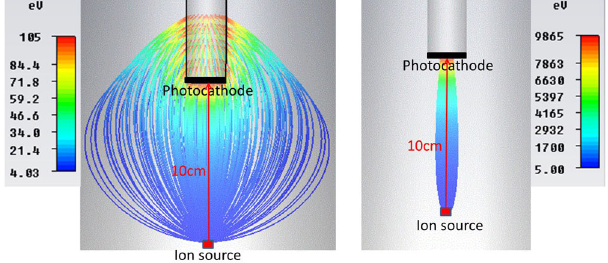
FIG. 5. Ion trajectory from the hydrogen ion source to the photocathode sample when the photocathode sample is biased at 100 V (left) and 10 000 V (right). Ions exit the dissociator glassware from a 1 mm diameter hole located approximately 10 cm beneath the photocathode